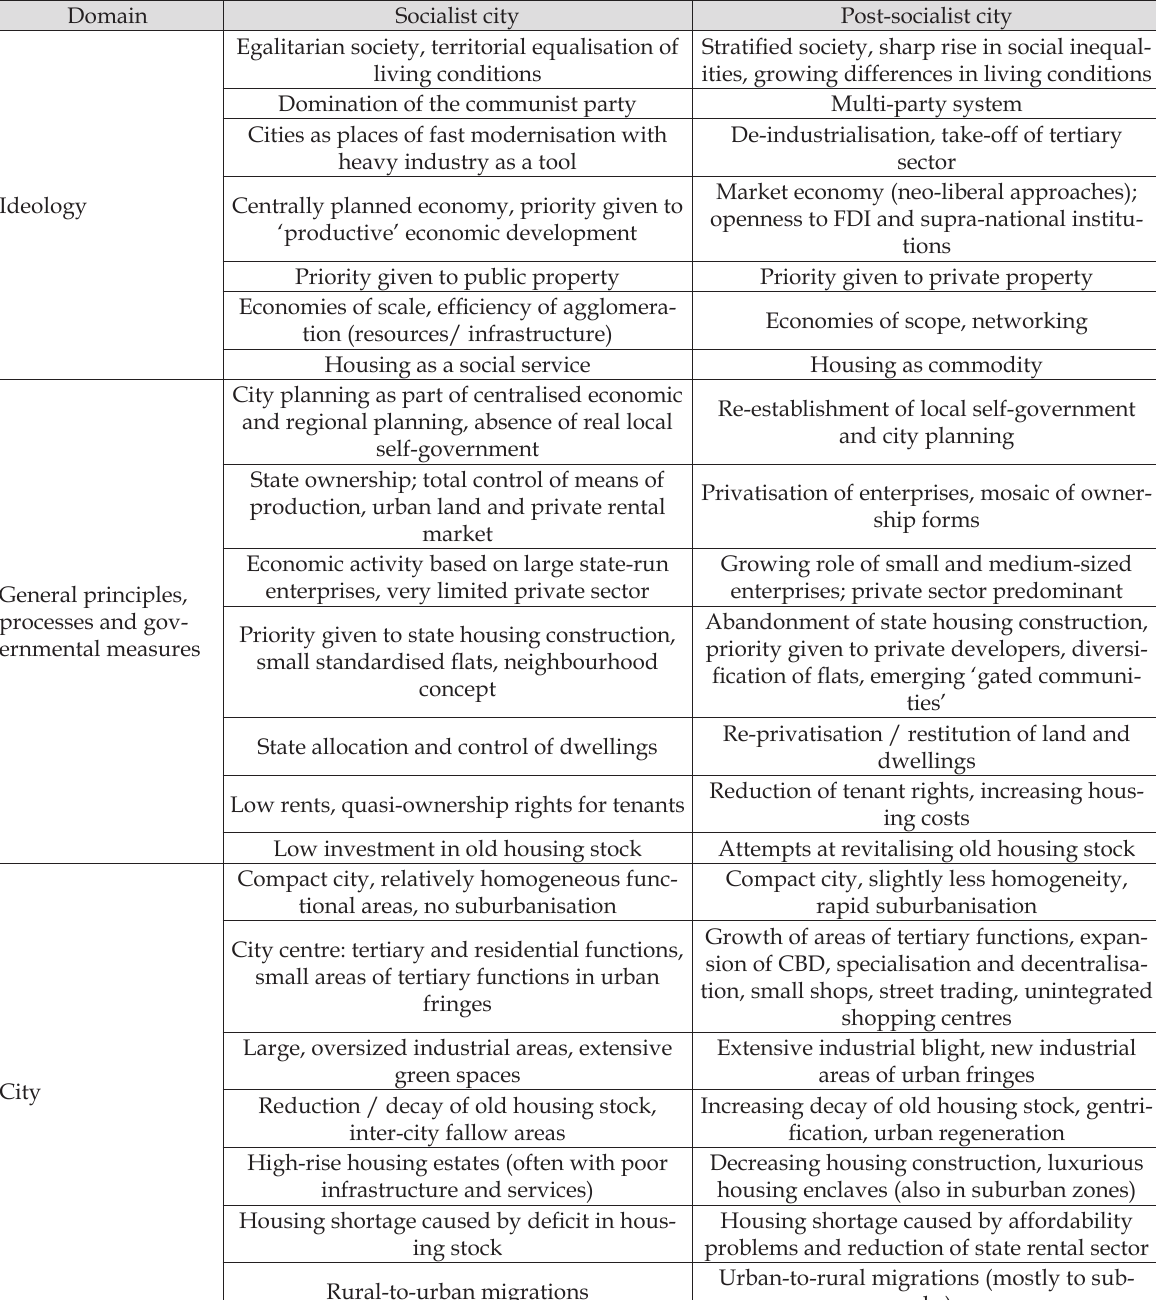
Table 1. Main characteristics of a socialist and a post-socialist city 21